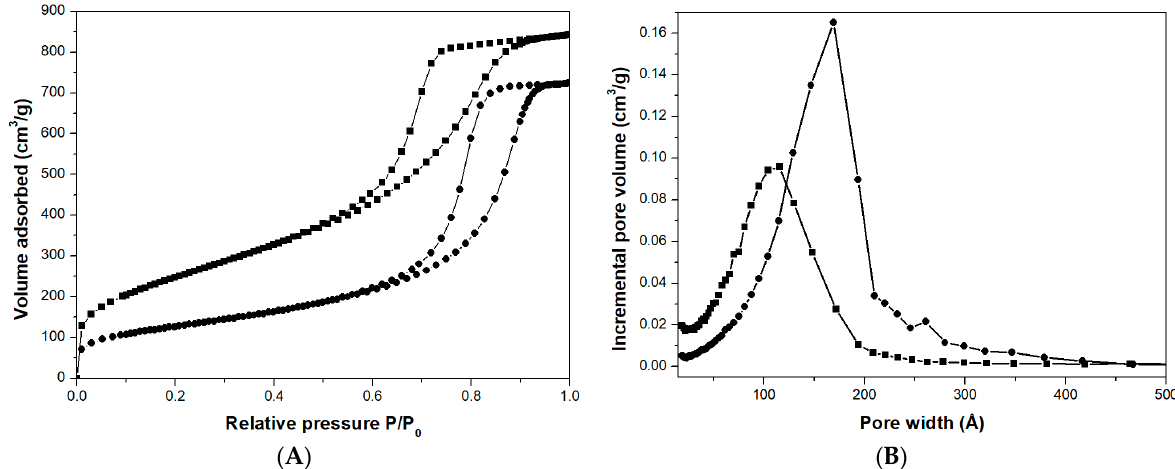
Figure 3. N 2 adsorption and desorption isotherms at 77 K ( A ) and pores size distribution ( B ) of calcined Mono-ICE-Lateral A ( (cid:4) ) and Mono-ICE-Lateral A-36h ( • ).